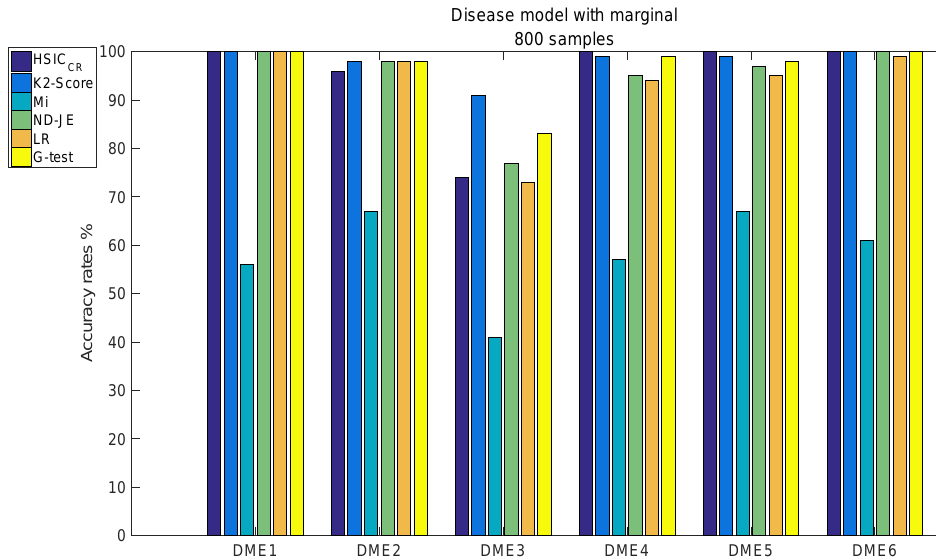
Figure 6. Disease model with marginal effects, with 800 samples and k = 2.